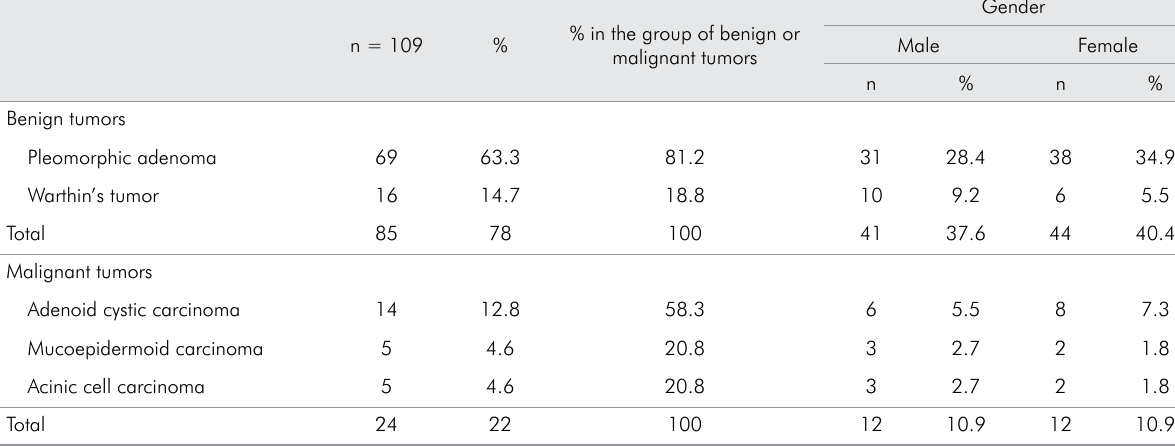
Table 2. Histologic and gender distribution of 109 salivary gland tumors.